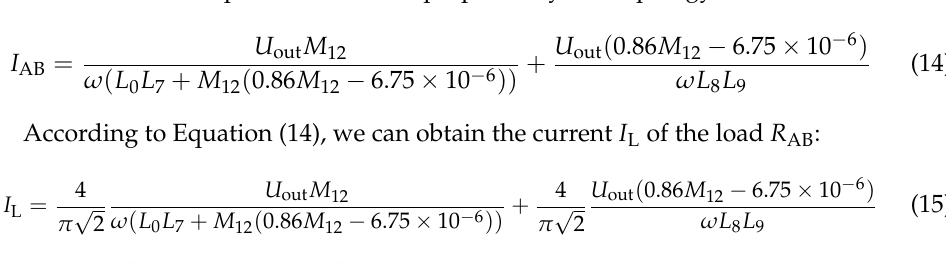
C 9 Rectifier Figure 10. Experimental set-up of the proposed hybrid IPT system. Figure 11. Output current of the proposed hybrid system .